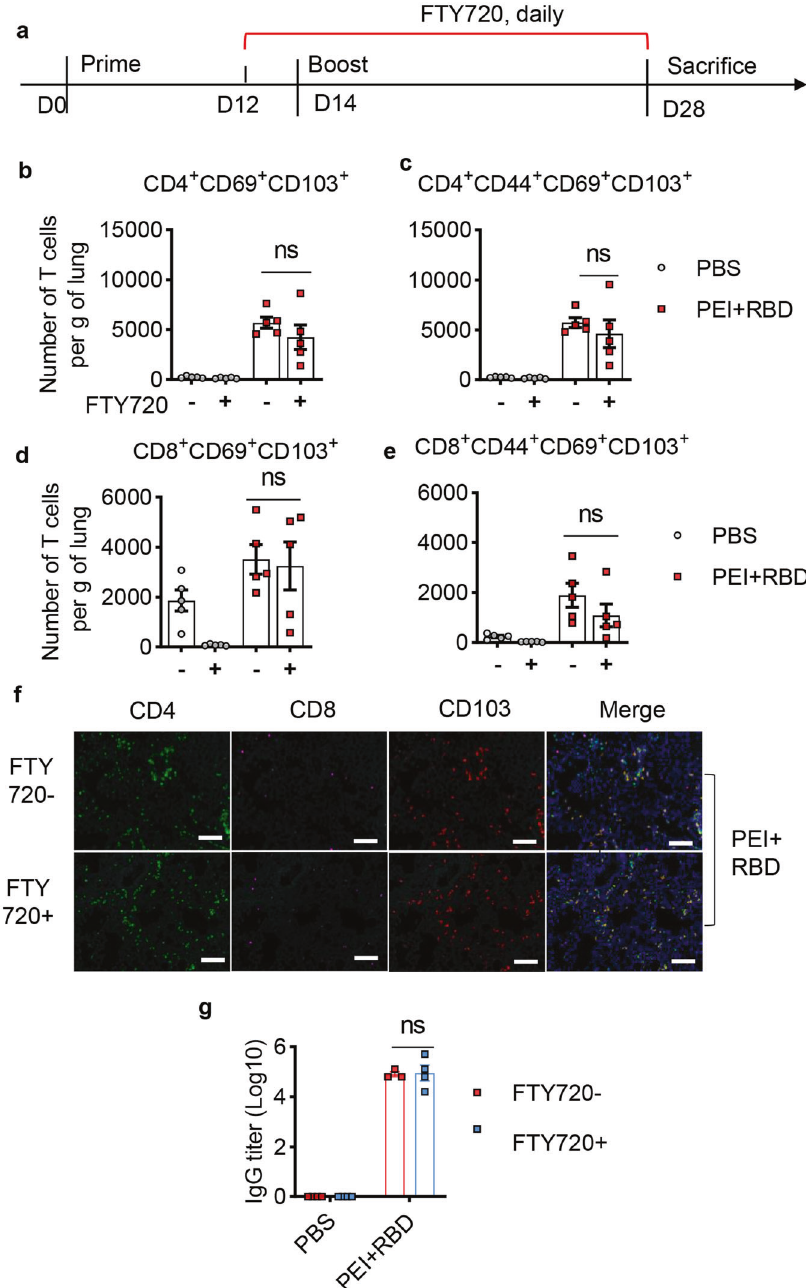
Fig. 7 Intranasal immunization with the adjuvanted RBD vaccine directly activates T cells in the lungs at boost. NIH mice were immunized with PBS or PEI-adjuvanted RBD vaccine on days 0 and 14 in the presence or absence of FTY720 treatment. On day 28, immunized mice were sacri fi ced. Lung tissues and serum samples were collected for the analysis of lung T-cell responses and serum IgG levels, respectively. a Schedule of vaccine delivery in the presence of FTY720 during boost immunization. Quanti fi cation of lung CD4 + ( b ), CD4 + CD44 + ( c ), CD8 + ( d ), and CD8 + CD44 + ( e ) T cells that highly express both CD69 and CD103 after boost immunization. f Immuno fl uorescence analysis of lung CD4 + and CD8 + T cells with elevated CD103 expression in immunized mice on 3dpi. Green, CD4; violet, CD8; red, CD103; blue, DAPI. Scale